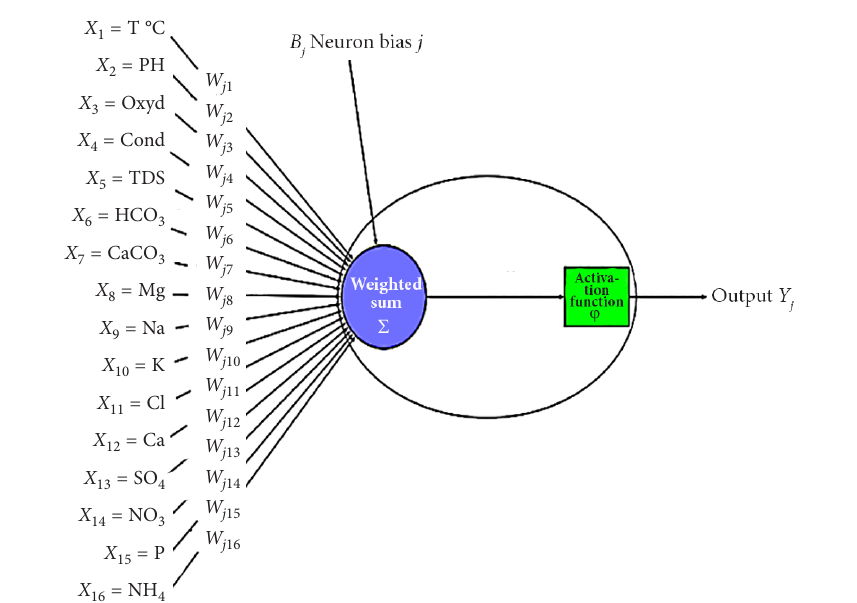
Figure 4. Model of a formal neuron with the sixteen Physico-chemical parameters as